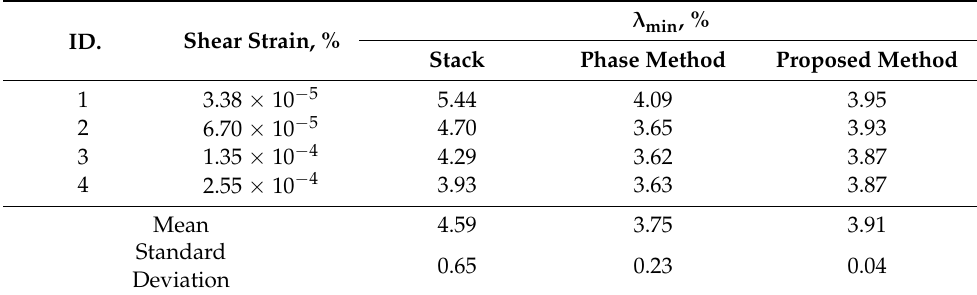
Table 2. Comparisons between the three